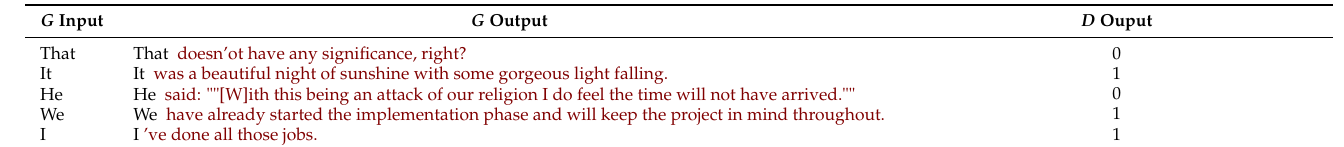
Table 4. We did not fine-tune the text generated by the previous GPT-2 medium model. Then, it is input to the discriminator for judgment. The red marker denotes the data generated by the generator, while a D Output of 0 indicates that the statement is not grammatically correct, and 1 indicates that it is grammatically correct.